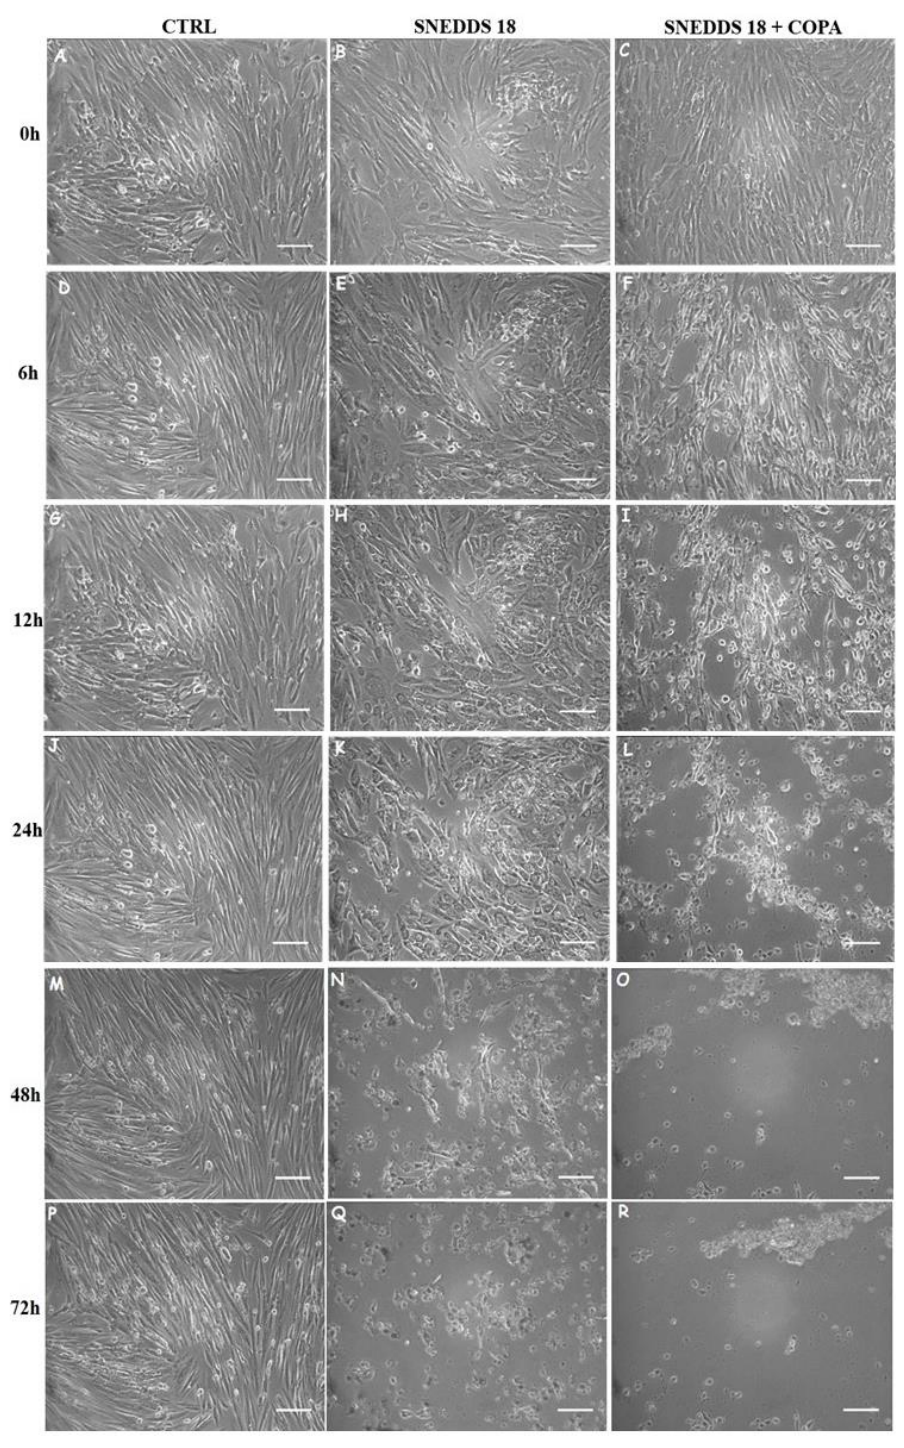
Figure 4. Alterations in EctESC cultures after treatment with SNEDDS-18 and SNEDDS-18/COPA. A-R are representative images of untreated and treated EctESC after incubation with nanoemulsions of SNEDDS-18 and SNEDDS-18/COPA (50 µ g/mL) obtained by phase contrast microscopy at 0 ( A – C ), 6 ( D – F ), 12 ( G – I ), 24 ( J – L ), 48 ( M – O ), and 72 ( P – R ) h. Scale bar = 50 µ m. CESC: Endometrial stromal cells obtained from topic endometrium of patients without endometriosis; EuESC: Endometrial stromal cells obtained from topic endometrium of endometriosis patients; EctESC: Endometrial stromal cells obtained from ectopic endometrium of endometriosis patients (endometriotic lesions). SNEDDS-18: Nanoemulsion containing Babassu oil. SNEDDS-18/COPA: Nanoemulsion containing Babassu oil and Copaiba oil